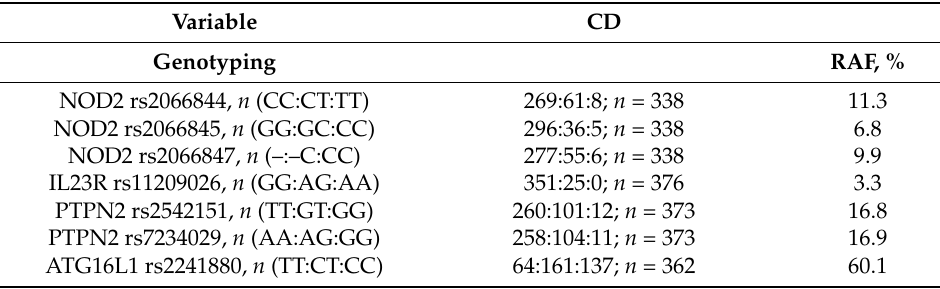
Table 3. Genotyping results.